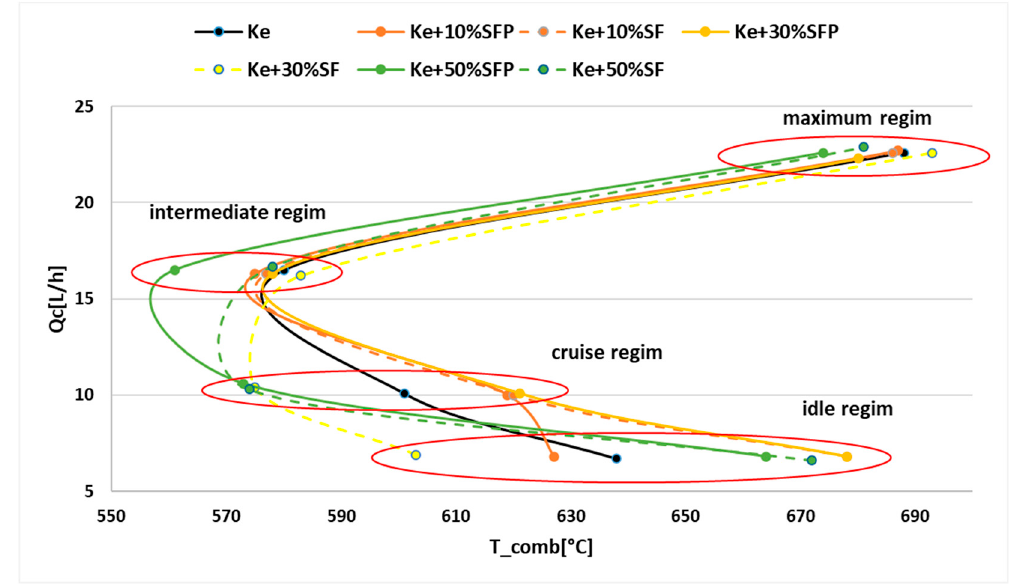
Figure 8. Correlation graph between Qc and T_comb.